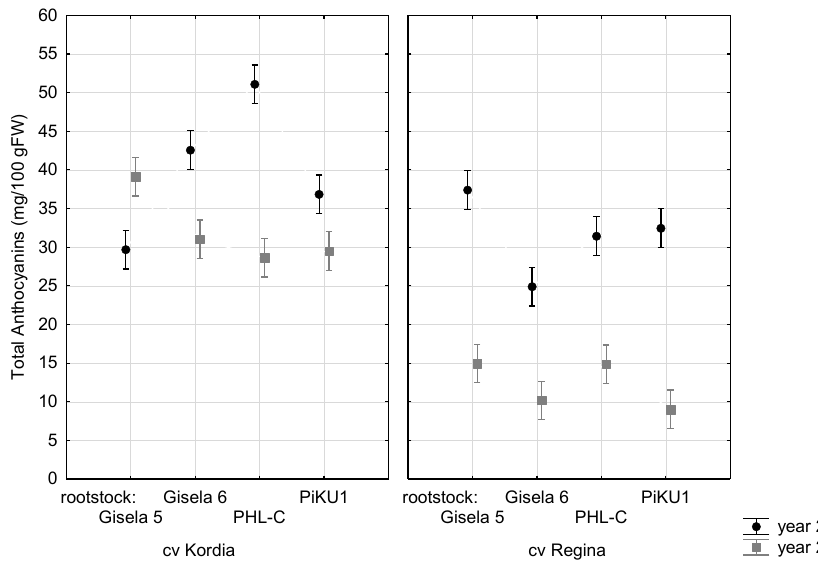
year 2013 year 2014cv